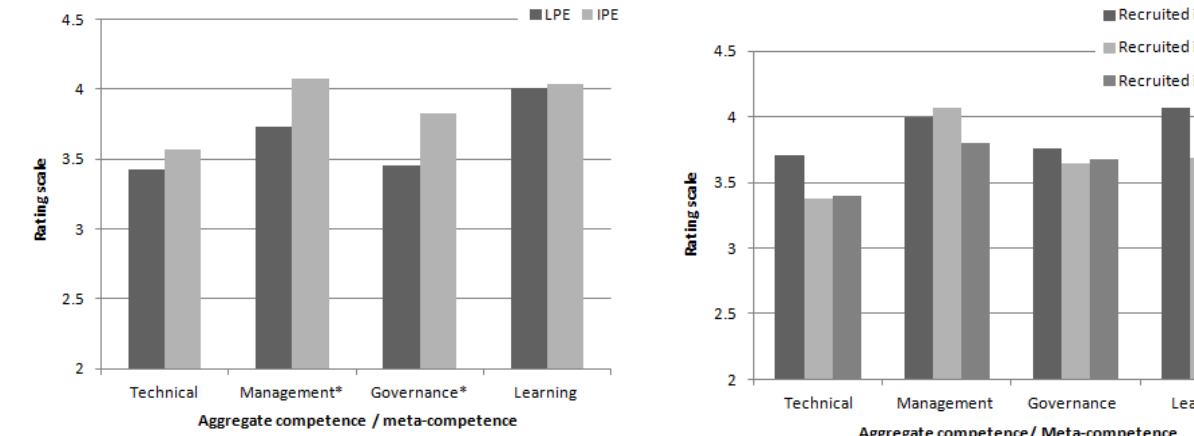
Fig. 3. Aggregate competences and meta-competence perceived to be required for daily tasks in the DGWR, in phase I (1970–1987), II (1987–1998) and III (1998–present); rating scale from 1 to 5, where 1=not at all, 3=to some extent, and 5=extensively.